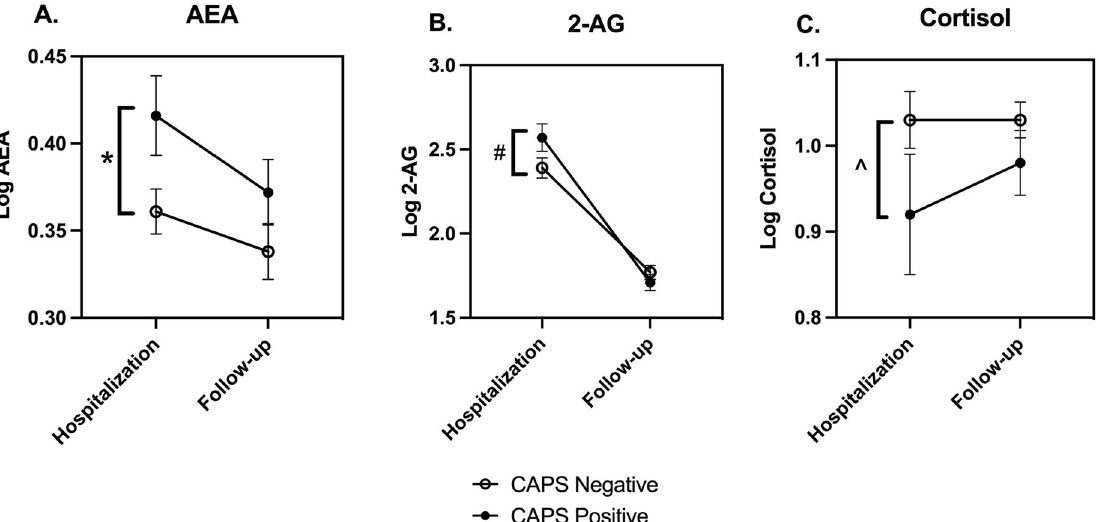
Fig. 3 Endocannabinoid and cortisol concentrations at hospitalization and 6 – 8 months after injury in those with and without CAPS diagnosis of PTSD. PTSD was diagnosed at the follow-up visit using the CAPS; AEA ( A ), 2-AG ( B ), and cortisol ( C ) concentrations were determined in serum from blood samples collected at the time of hospitalization and at follow-up, which occurred 6 – 8 months following hospital discharge. Each data set was analyzed by two-way ANOVA and planned comparisons between PTSD positive and negative groups were made at each time point (i.e., hospitalization and follow-up). The ANOVA results are: AEA: Time F (1,312) = 3.42, p = 0.066; PTSD F (1,312) = 6.03, p = 0.015; Interaction F (1,312) = 0.34, p = 0.56; 2-AG: Time F (1,312) = 130, p < 0.0001; PTSD F (1,312) = 0.86, p = 0.35; Interaction F (1,312) = 3.43, = 0.60, p = 0.44; PTSD F = 4.03, p < 0.05; Interaction F = 0.60, p = 0.44. Symbols represent mean p = 0.065; and cortisol: Time F (1,315) (1,315) (1,315) and vertical lines indicate SEM. * p < 0.05; # p = 0.08, and ^ p = 0.09 by Sidak ’ s multiple comparison